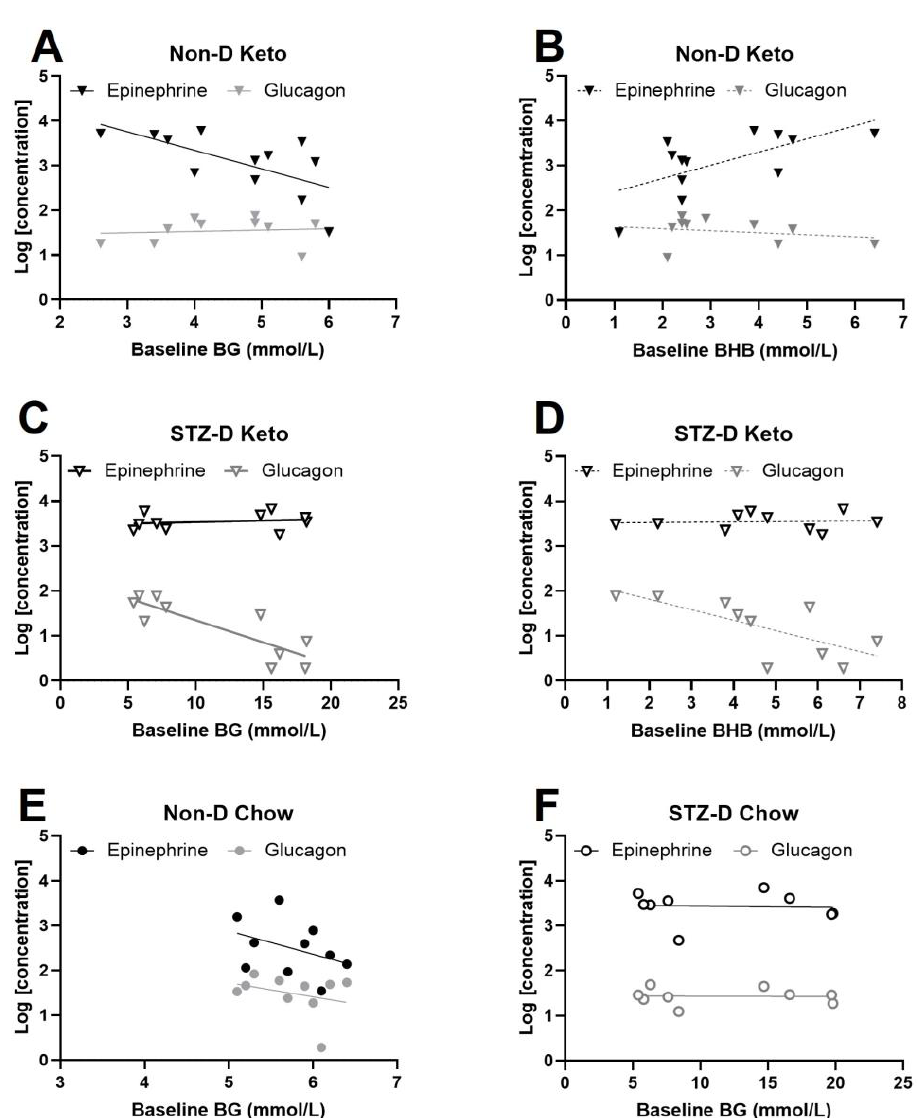
Figure 5. Baseline BG and BHB correlate with post-hypoglycemic epinephrine. Plasma epinephrine and glucagon concentrations were measured in animals subjected to a single (1 × -Hypo) or recurrent (3 × -Hypo) insulin injections; in the 3 × -Hypo groups epinephrine and glucagon were measured after the final insulin injection. ( A ) In non-diabetic keto-fed rats baseline BG inversely correlated with plasma epinephrine, but not glucagon, measured 2 h after insulin injection ( n = 12); ( B ) Direct correlation was detected between baseline BHB and epinephrine in non-diabetic keto-fed rats, and no correlation with glucagon; ( C ) Baseline BG did not correlate with epinephrine or glucagon in STZ-diabetic keto-fed rats ( n = 10); ( D ) Baseline BHB significantly correlated with glucagon, but not epinephrine in STZ-diabetic keto-fed rats; ( E ) Baseline BG was not associated with changes in epinephrine or glucagon in non-diabetic chow-fed rats ( n = 10) or ( F ) STZ-diabetic chow-fed rats ( n = 9). Concentrations of epinephrine ang glucagon (pg/mL) were log-transformed for analysis. Data analysed by Spearman’s correlation. Datapoints are individual animals.